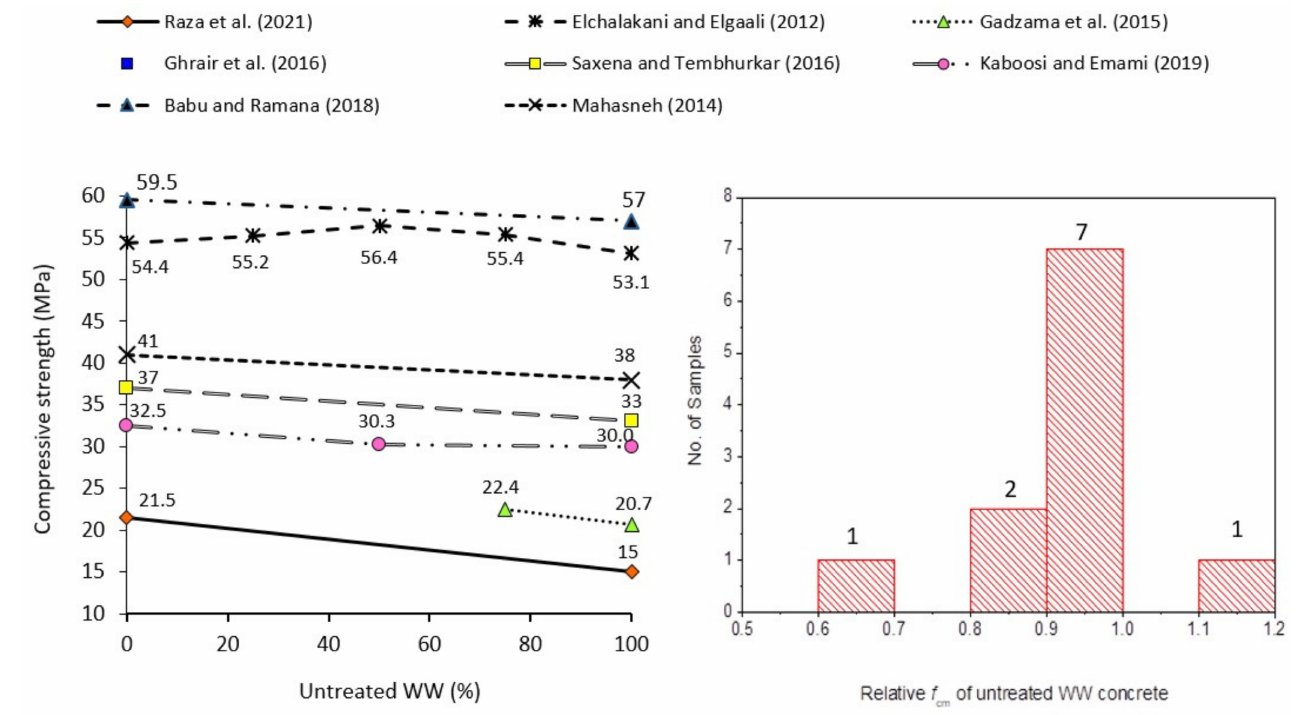
Figure 6. Effect of untreated WW on the compressive strength of